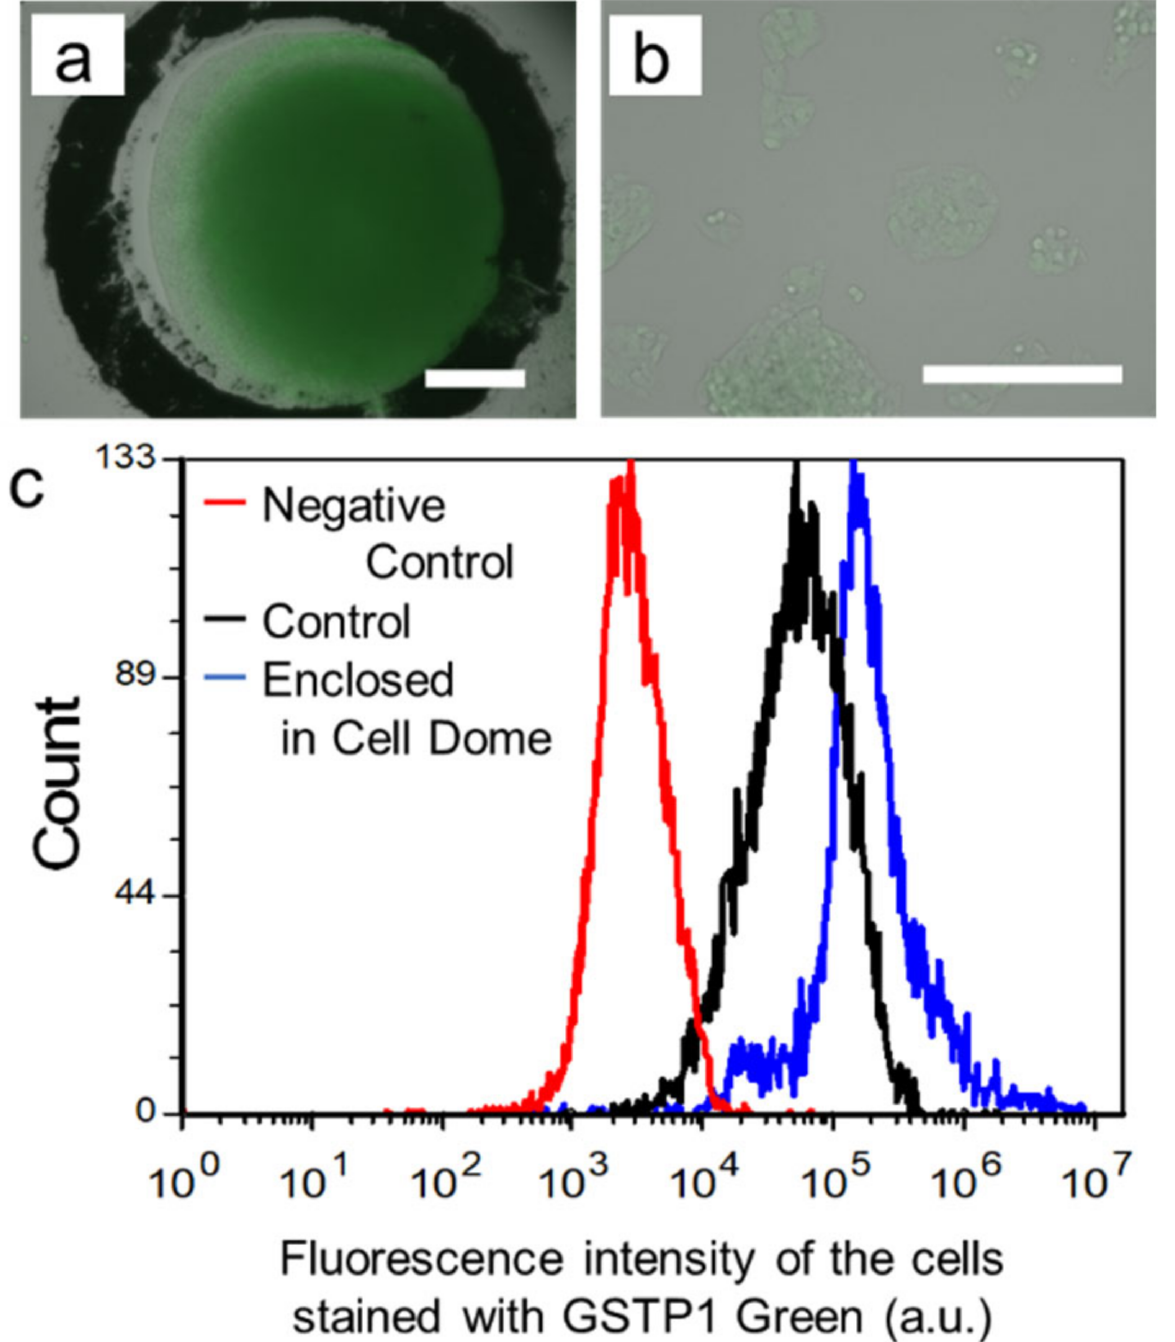
Figure 3. ( a , b ) Fluorescence observation of HepG2 cells in Cell Domes after 18 days of culture ( a ) and 2D-cultured cells on a tissue culture dish ( b ) both stained with GSTP1 Green. Bars: 250 µ m. ( c ) Flow cytometry analysis data of the cells not stained with GSTP1 Green (Red line: Negative Control) and stained with GSTP1 Green enclosed in Cell Domes after 18 days of culture (Blue line) and 2D-cultured cells on a tissue culture dish stained with GSTP1 Green (Black line: Control). * p < 0.05 vs. 2D-cultured cells with and without staining GSTP1